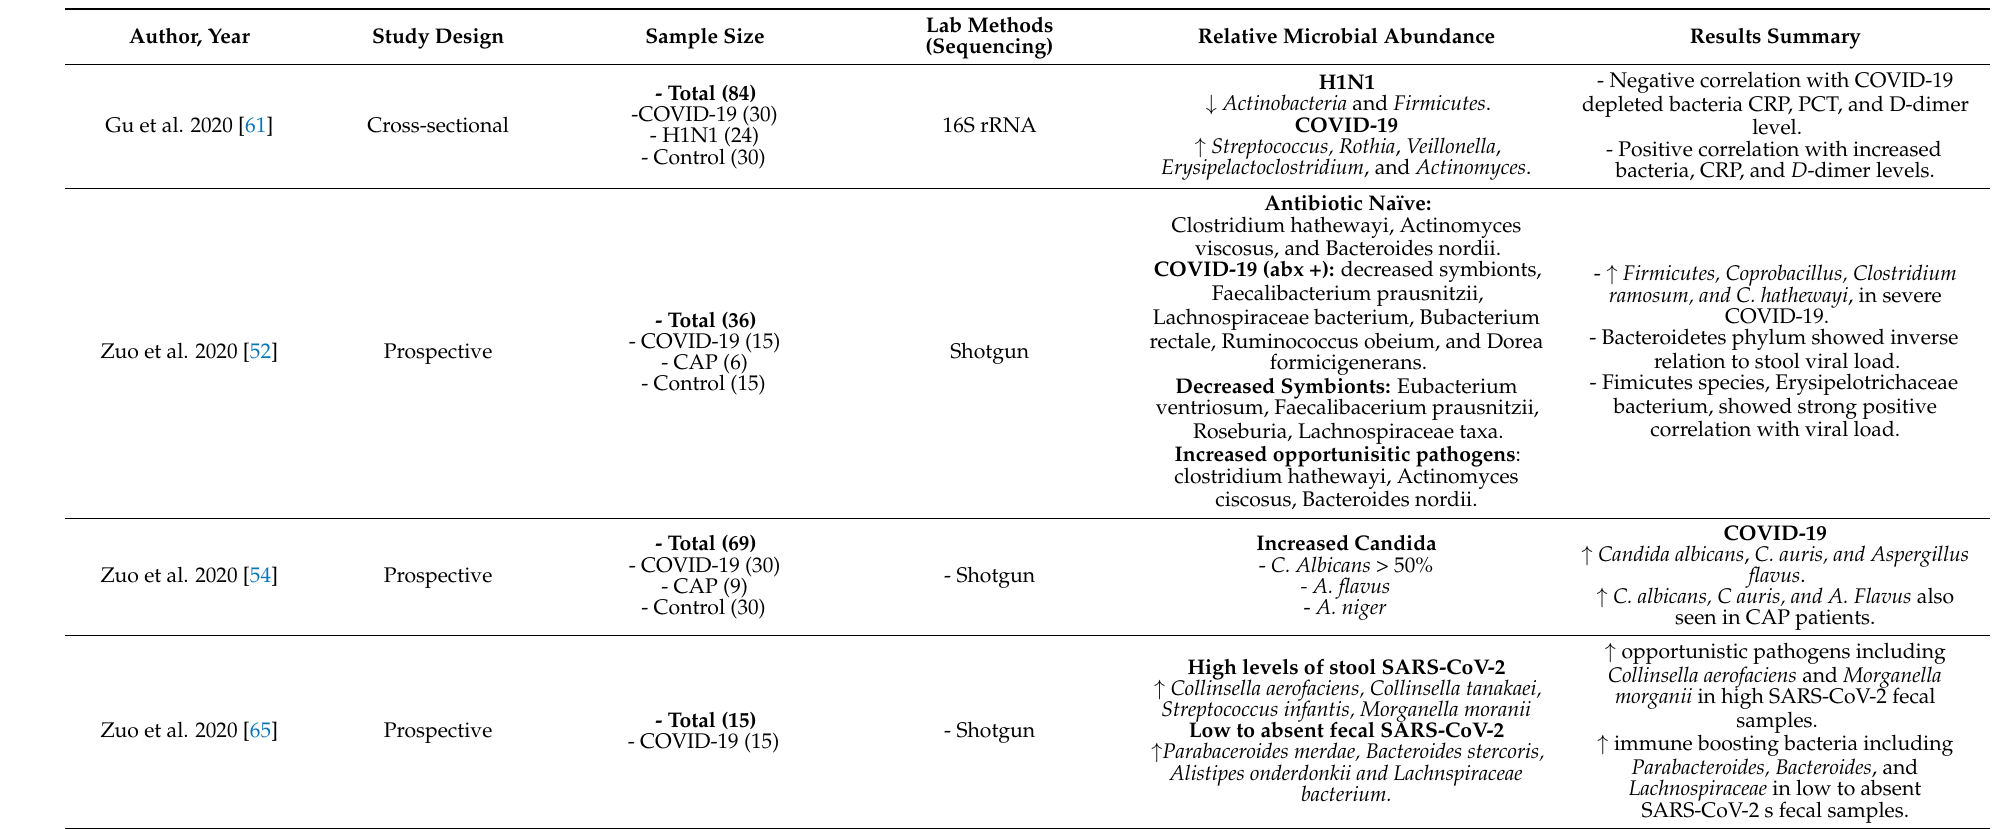
Table 3. COVID-19 and the gut microbiota in clinical